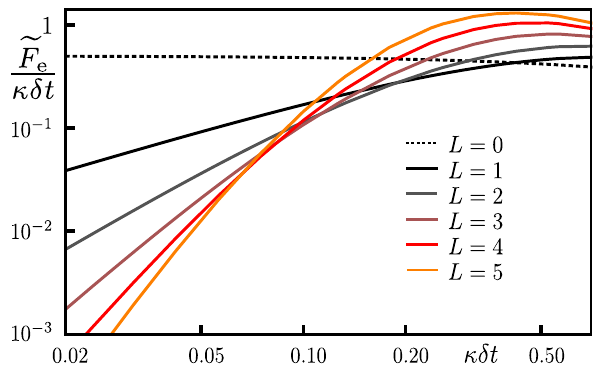
~ F = δ t for a fully FIG. 2. The rate of entanglement infidelity e mixed logical qubit state plotted as a function of the time step δ t (notice the logarithmic scale of both axes) for the binomial codes (7) with S ¼ N ¼ L ¼ 1 (black), 2 (gray), 3 (brown), 4 (red), and 5 (orange). Here, we have assumed a perfectly faithful recovery process. The dashed line shows the performance of the naive encoding L ¼ 0 , j W i ↑ = ↓ i ¼ j 0 = 1 i , whose rate of entanglement infidelity at small δ t approaches κ = 2 corresponding to the rate of a photon loss with ¯ n ¼ 1 = 2 . Entanglement infidelity [92] is calculated as P 1 W W where ˆ ρ σ ih σ j is the fully mixed state of the logical σ j 2 c ¼ code words. The entanglement infidelity for a fully mixed state is equal to the process infidelity 1 − χ II of a quantum memory. For an ideal quantum memory, χ II ¼ 1 and the full quantum process is just an identity operation [64]. At a small time step δ t , the ~ F = δ t agree well with the slopes for the rate of the slopes of e = δ t . The binomial code with leading uncorrectable error P L þ 1 L ¼ 1 outperforms the naive encoding for time steps δ t ≲ 0 . 4 κ − 1 , and the codes with L > 1 become favorable when δ t ≲ 0 . 2 κ − 1